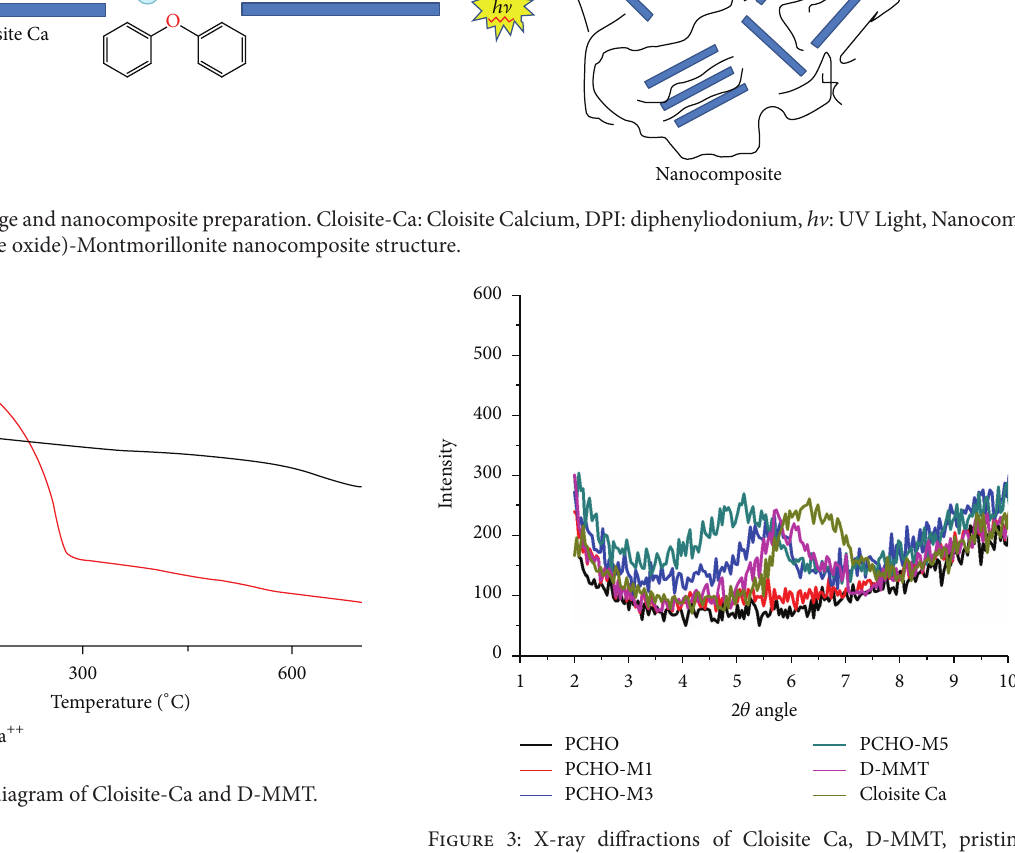
Figure 3: X-ray diffractions of Cloisite Ca, D-MMT, pristine polymer, and clay-loaded